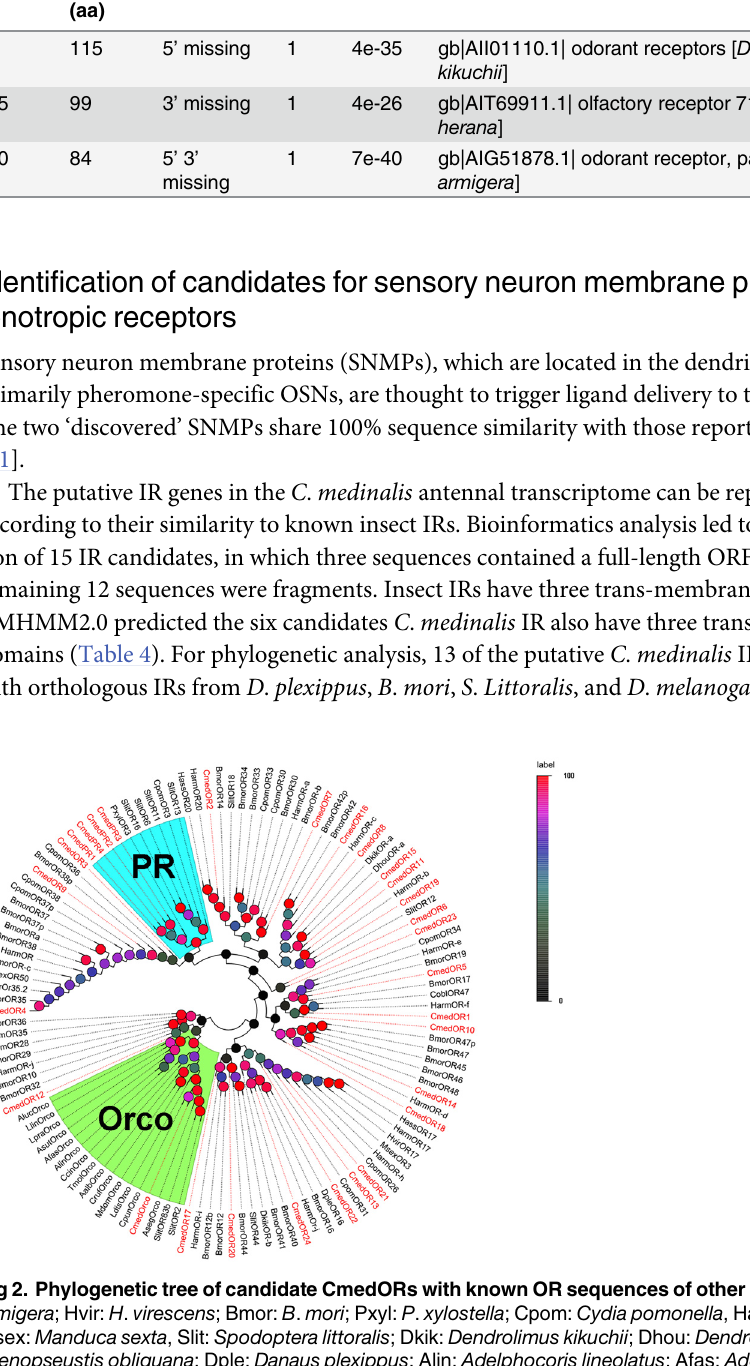
Fig 2. Phylogenetic tree of candidate CmedORs with known OR sequences of other species. Harm: H . armigera ; Hvir: H . virescens ; Bmor: B . mori ; Pxyl: P . xylostella ; Cpom: Cydia pomonella , Hass: H . assulta ; Msex: Manduca sexta , Slit: Spodoptera littoralis ; Dkik: Dendrolimus kikuchii ; Dhou: Dendrolimus houi ; Cobl: Ctenopseustis obliquana ; Dple: Danaus plexippus ; Alin: Adelphocoris lineolatus ; Afas: Adelphocoris fasciaticollis ; Asut: Adelphocoris suturalis ; Lpra: Lygus pratensis ; Llin: Lygus lineolaris ; Aluc: Apolygus lucorum ; Tmol: Tenebrio molitor ; Ccin: Cephus cinctus ; Mdom: Musca domestica ; Cruf: Chrysomya rufifacies ; Aalb: Aedes albopictus ; Ldis: Lymantria disparasiatica ; Cpun: Conogethes punctiferalis ; Aseg: Agrotis segetum ; The clades in blue and in green indicate the pheromone receptor gene clade and the co- receptor gene clade